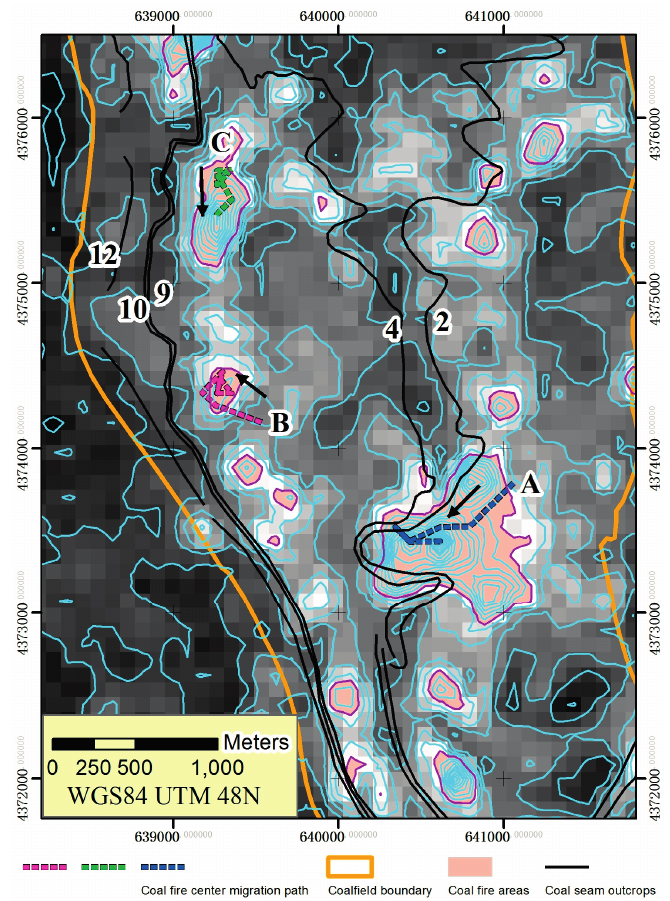
Figure 5. The migration map of the fire centers. The point with the highest temperature in the coal fire area is considered the fire center. The background temperature, coal fire areas, and contours correspond to 21 April 2008. ( A ) The fire center in coal fire zone 11 migrated from east to west (from a deep part to a shallow part); ( B ) the fire center in coal fire area No. 8 moved from east to west (from a deep part to a shallow part); ( C ) the fire center in coal fire area No. 8 moved from north to south, along the coal seam outcrops or a coal seam strike. As shown in Figure 5, fire center A moved within the largest coal fire area (fire zone No. 11). In the period from late 2006 to early 2008, this center moved from the east to the west, corresponding to a shift from a deep to a shallow area of the seam. We deduced that the coal fires were first ignited deep in the coal seam rather than in the exposed outcrops. Otherwise, the coal fire center would have moved along the coal seam from a shallow area to a deeper area. In a technical report, Shenhua reported that the fire in Zone 11, where center A was located, had a maximum burning depth of 76 m below surface [20]. We infer that these coal fires could be ignited from closed former goaf, where the residual high-sulfur-content coal is prone to spontaneous combustion in the laneways, rather than in coal mining faces with machinery present, where the ventilation system prevents the concentration of heat. This trend also agrees with the majority coal fire causes, i.e. , spontaneous in mine goaf [21]. In fire zone No. 8, fire center B exhibited deep to shallow movement (from east to west) and fire center C was observed to migrate along the strike of the coal seam. Due to the limited presence of heavy machinery, artisan mining activities start at the outcropping coal seams. Thus, it is inferred that this coal fire area might have ignited at wasted artisan mines and